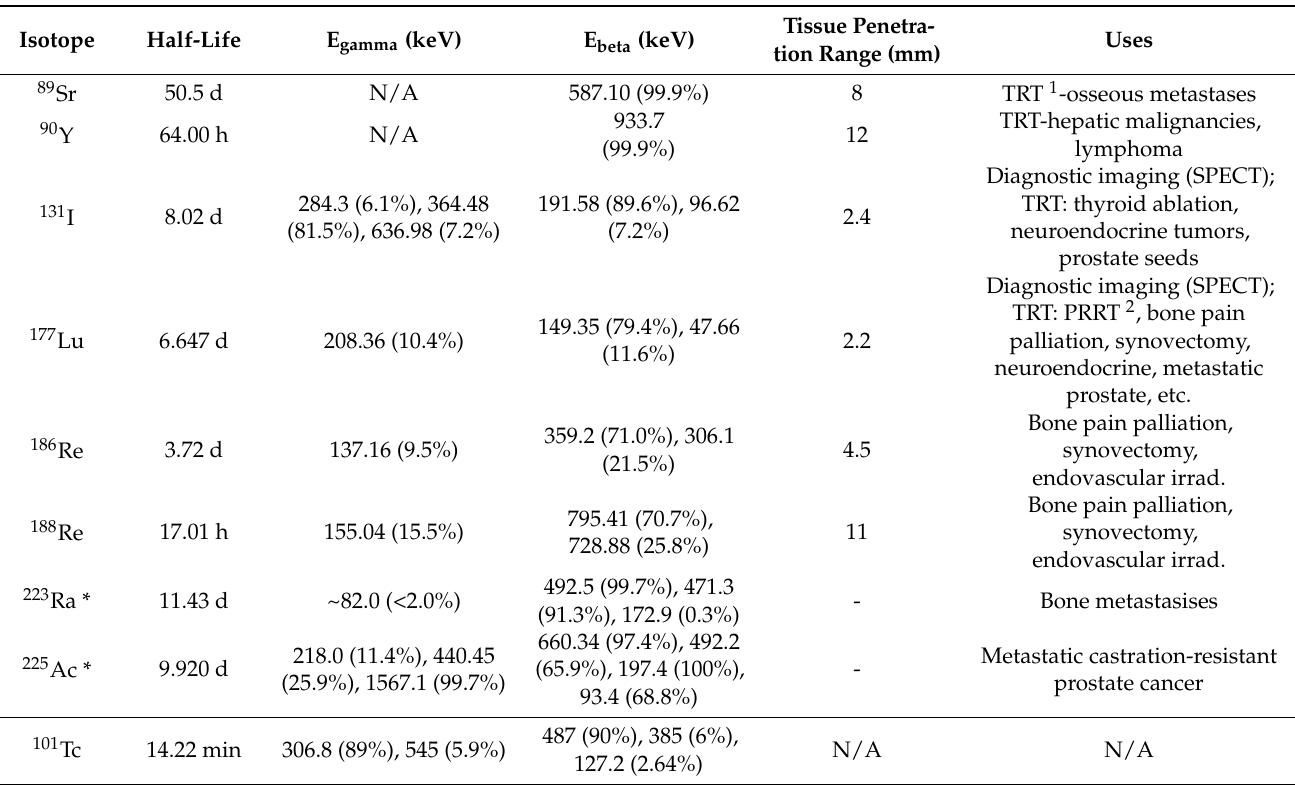
Table 5. Comparison of nuclear data for commercial radioisotopes used for therapeutic/theranostic applications [87] with 101